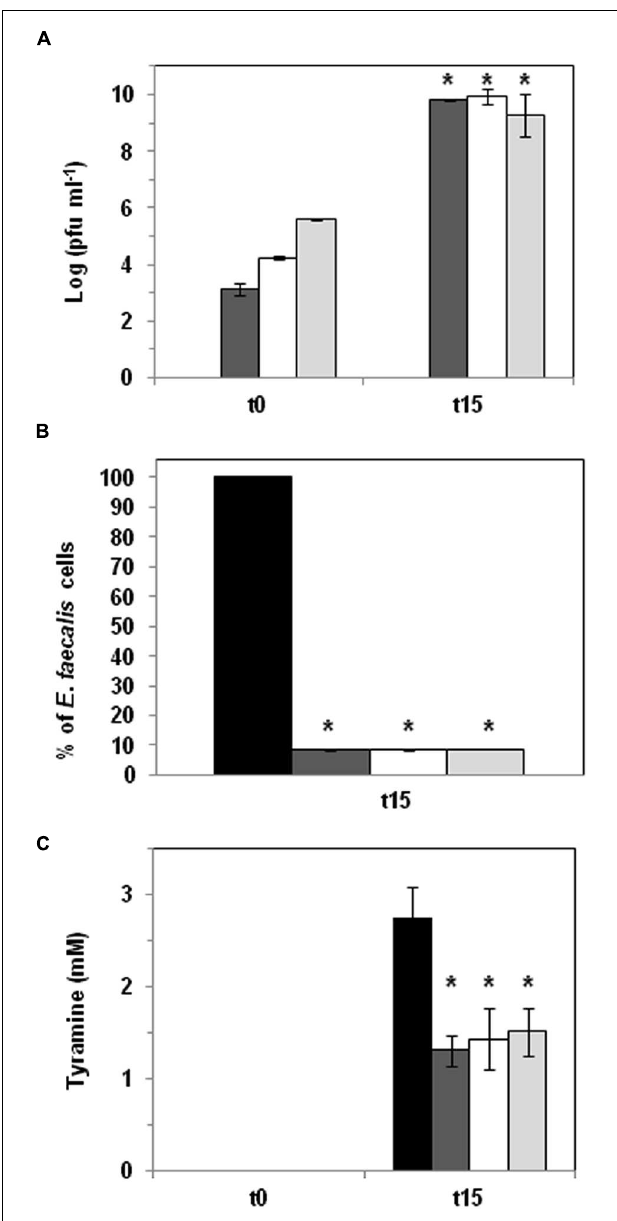
FIGURE 3 | Phage biocontrol assay in broth medium. E. faecalis was challenged with phage Q69 at three different MOIs (dark gray bar 0.1, white bar 1, and light gray bar 10) in CM-GM17 supplemented with 5 mM tyrosine. Black bars represent control cultures without Q69 phage. (A) Number of Q69 phage particles (log pfu ml − 1 ) at the beginning of the assay (t0) and after 15 h of incubation (t15). No phages were detected in control cultures (therefore no corresponding black bars appear). An asterisk indicates a significant difference ( ∗ p < 0.05; Student’s t -test) with respect to t0. (B) Percentage reduction in E. faecalis counts after 15 h of incubation at 30 ◦ C. The black bar represents the number of E. faecalis 23a cells in control culture without phage Q69 after 15 hours of incubation (100 %). An asterisk indicates a significant difference ( ∗ p < 0.05; Student’s t- test) with respect to control cultures (black bar). (C) Tyramine concentration (mM) measured by UPLC at the beginning of the assay (t0) and after 15 hours of incubation (t15). An asterisk indicates a significant difference ( ∗ p < 0.05; Student’s t -test) with respect to control cultures (black bar).